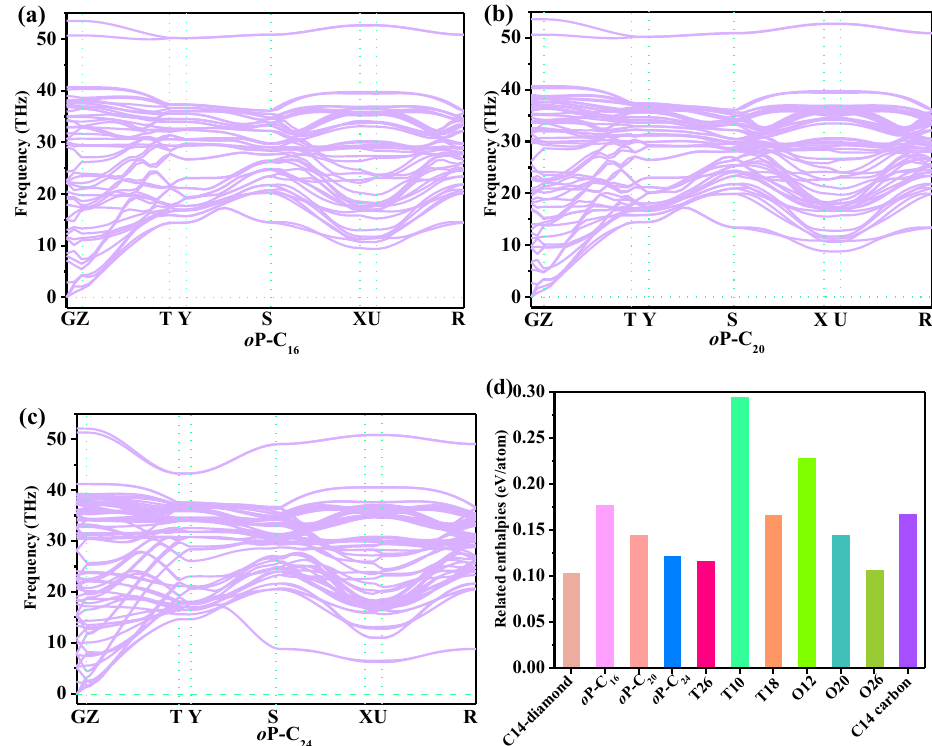
Figure 1: Phonon spectra of o P - C 16 ( a ) , o P - C 20 ( b ) , and o P - C 24 ( c ) , and the related enthalpies of other metallic carbon allotropes ( d )